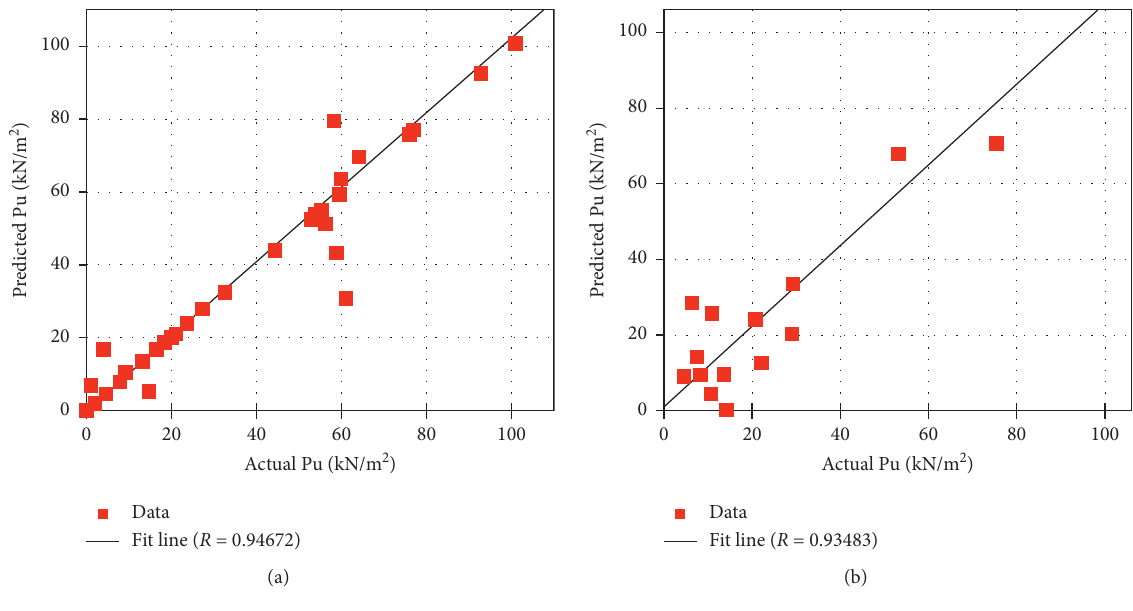
Figure 6: ANN regression results for (a) training and (b) testing. Table 2: Comparison of experimental results and ANN model results with error